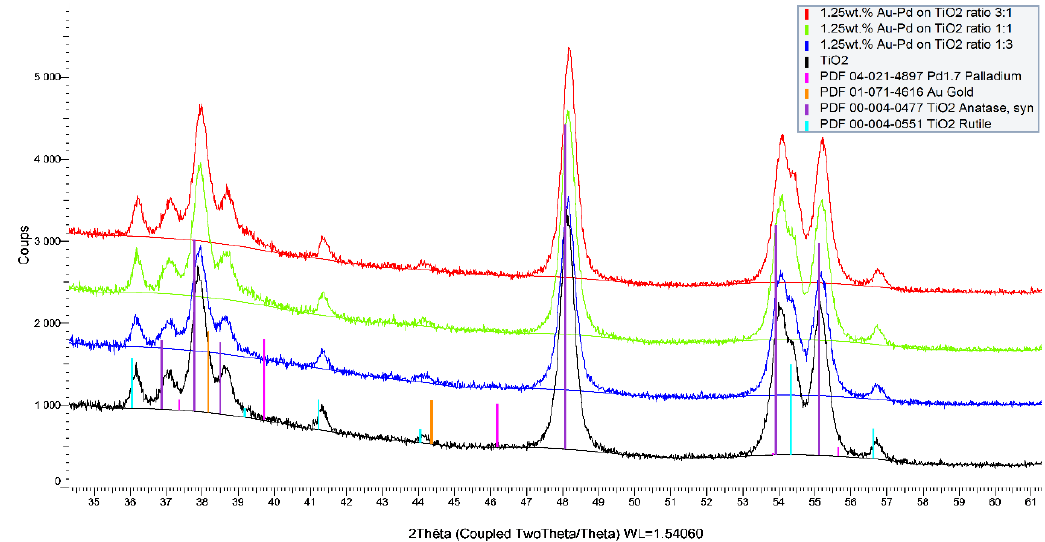
Figure 2. X-ray diffractograms of 1.25 wt.% of Au-Pd/TiO 2 catalysts with Au-Pd molar ratio of 3:1, 1:1, and 1:3.